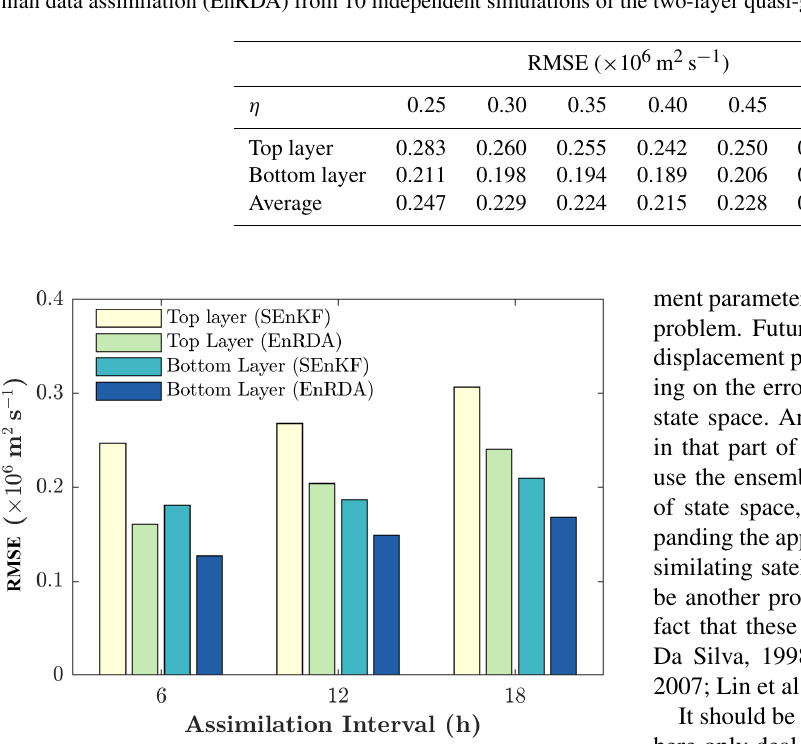
Table 1. Average root mean squared error (RMSE) values as a function of the displacement parameter η ∈ [ 0 . 25 , 0 . 6 ] for ensemble Rieman- nian data assimilation (EnRDA) from 10 independent simulations of the two-layer quasi-geostrophic model.